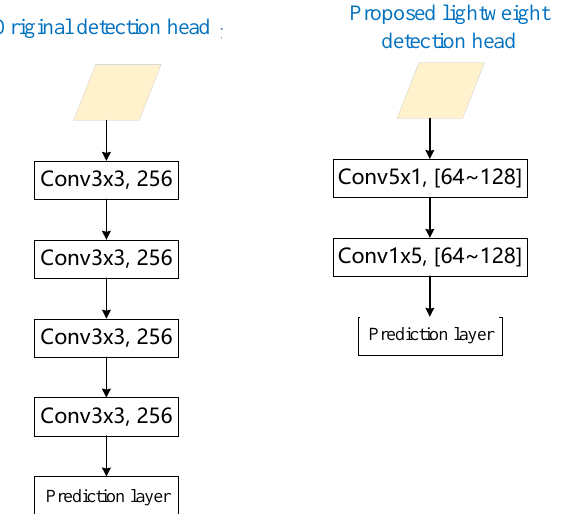
Figure 5. Improvement of our lightweight detection head.